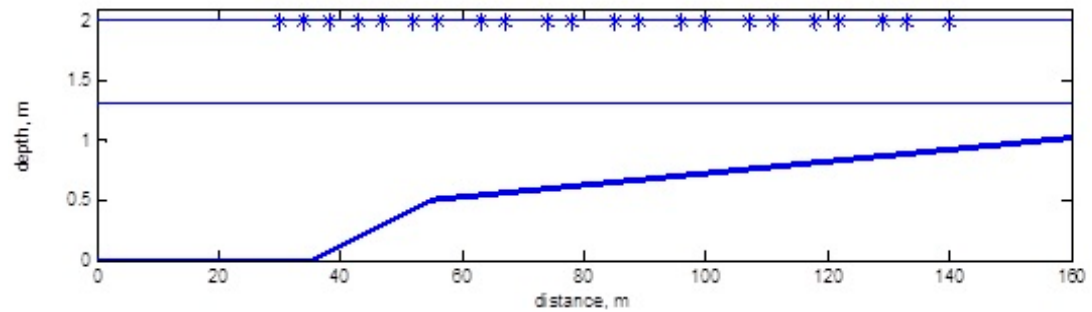
Figure 5. Schematic view of the experimental setup, —wave gauges.